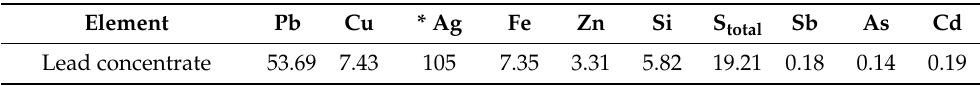
Table 1. Chemical Analysis in wt.% of as received lead concentrate sample.